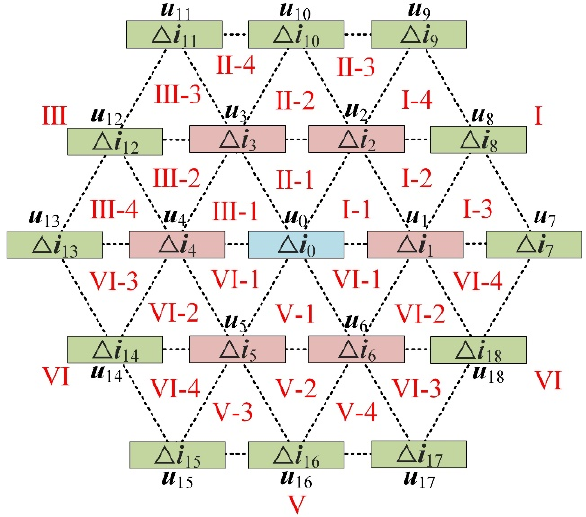
Figure 5. Big and small sectors of the three-level three-phase inverter.